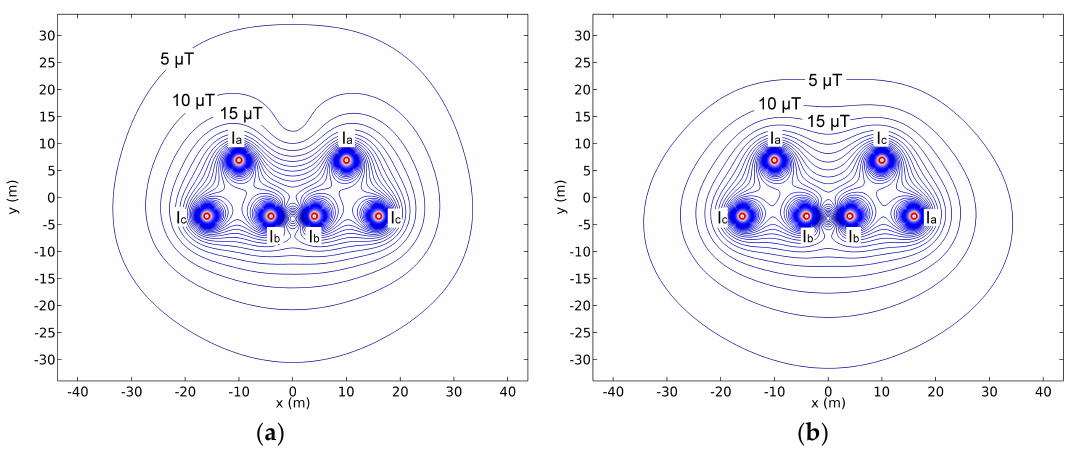
Figure 4. MF levels for a double circuit line in two phase arrangements, ( a ) super-bundle and ( b ) low reactance line (based on [13], CIGRÉ 2009).